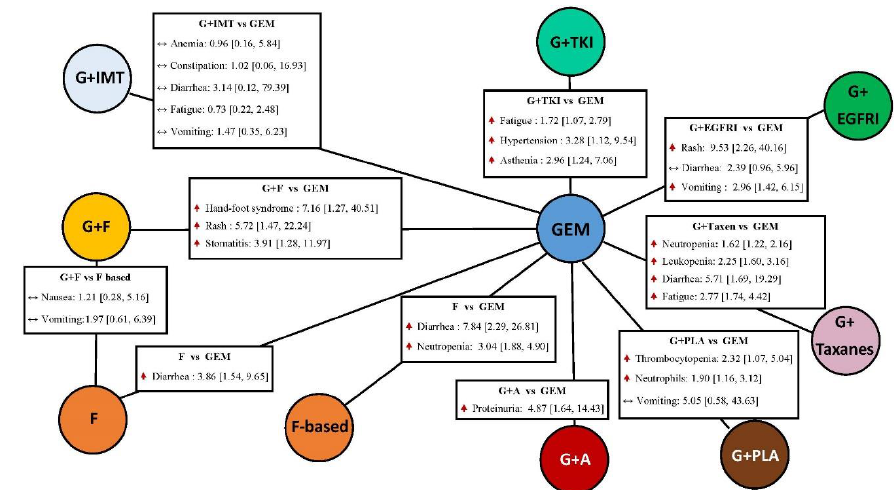
Figure 2. Pairwise comparisons of toxicities: experimental therapy vs. gemcitabine alone. Data presented as odds ratio (OR) with 95% confidence interval (CI); the 95% confidence interval that did not contain the value of 1 represents as statistical significance. PLA: doublet platinum-based treatment; GEM: gemcitabine; F: fluoropyrimidine only; F-based: fluoropyrimidine-based treatment; EGFRI: epidermal growth factor receptor inhibitor; ANGI: angiogenesis inhibitor; IMT: immunotherapy; TKI: tyrosine kinase